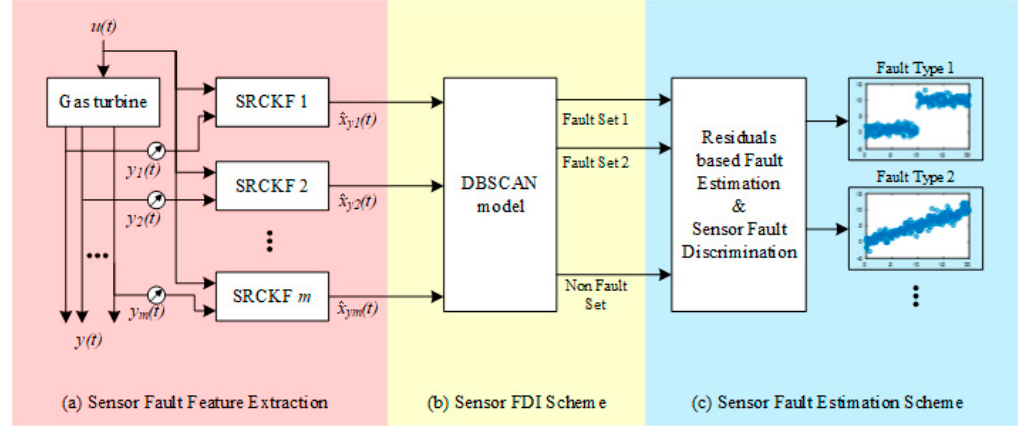
Figure 1. Sensor FDI&E scheme based on SRCKF and DBSCAN.